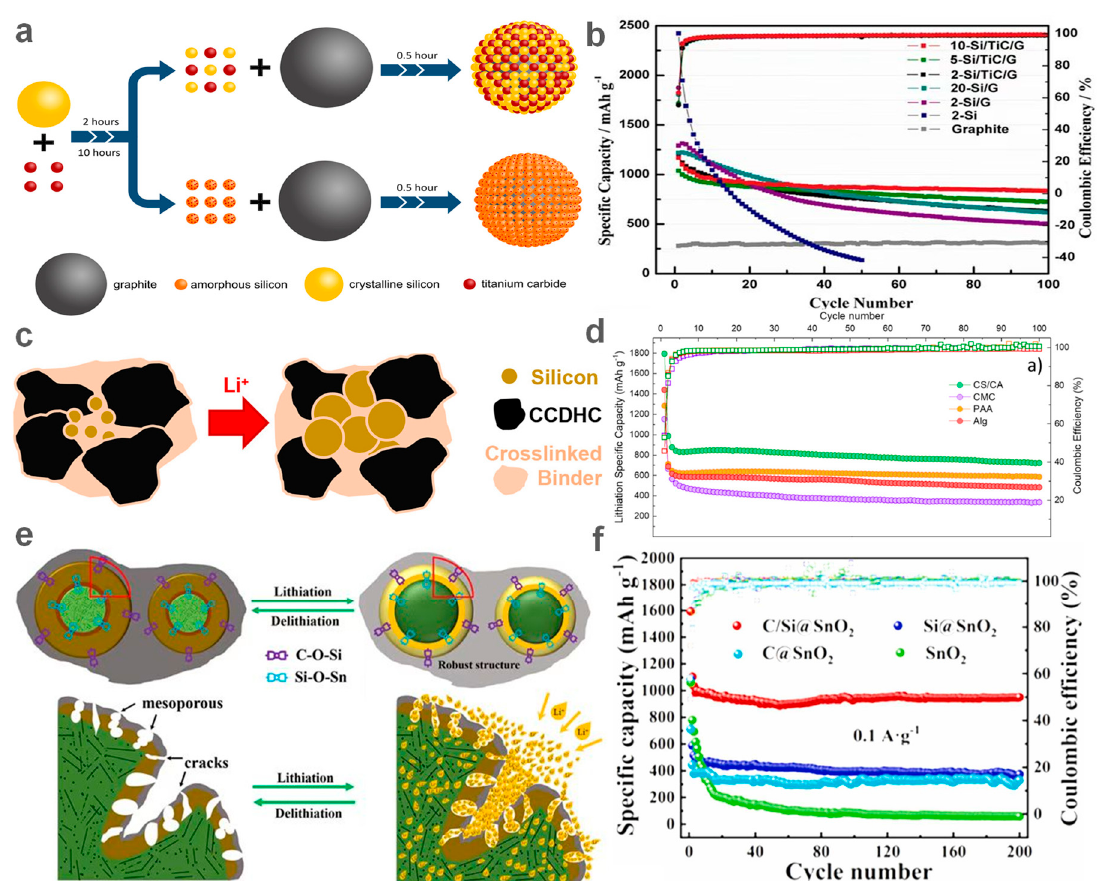
Figure 4. ( a ) Schematic of the preparation processes of Si/TiC/G composites. ( b ) Cycle performance of Si/G and Si/TiC/G electrodes with different ball-milling times at 0.2 C. Reproduced with permis- sion [68]. Copyright 2021, Springer Nature. ( c ) Schematic diagram of working volume change in Si/CCDHC composite. ( d ) Comparison of galvanostatic cycling of Si/CCDHC employing different binders at 1.0 A g − 1 (CS/CA = green, sodium carboxymethyl cellulose (CMC) = violet, polyacrylic acid (PAA) = orange, sodium alginate (Alg) = red). Reproduced with permission [69]. Copyright 2022, American Chemical Society. ( e ) Reaction mechanism diagrams and diagram of Li + diffusion of the C/Si@SnO 2 . ( f ) Cycle curves of C/Si@SnO 2 , Si@SnO 2 , C@SnO 2 , and SnO 2 electrodes at 0.1 A·g − 1 . Reproduced with permission [70]. Copyright 2022, Elsevier B. V.